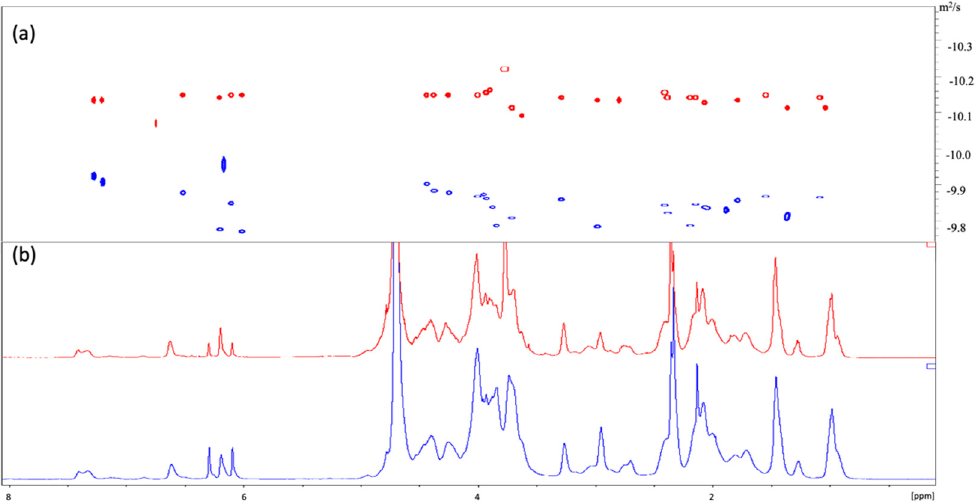
Figure 4. ( a ) Diffusion ordered spectroscopy NMR (DOSY) and ( b ) 1H spectra of blend (blue) and hydrogel (red) at the end of kinetics.